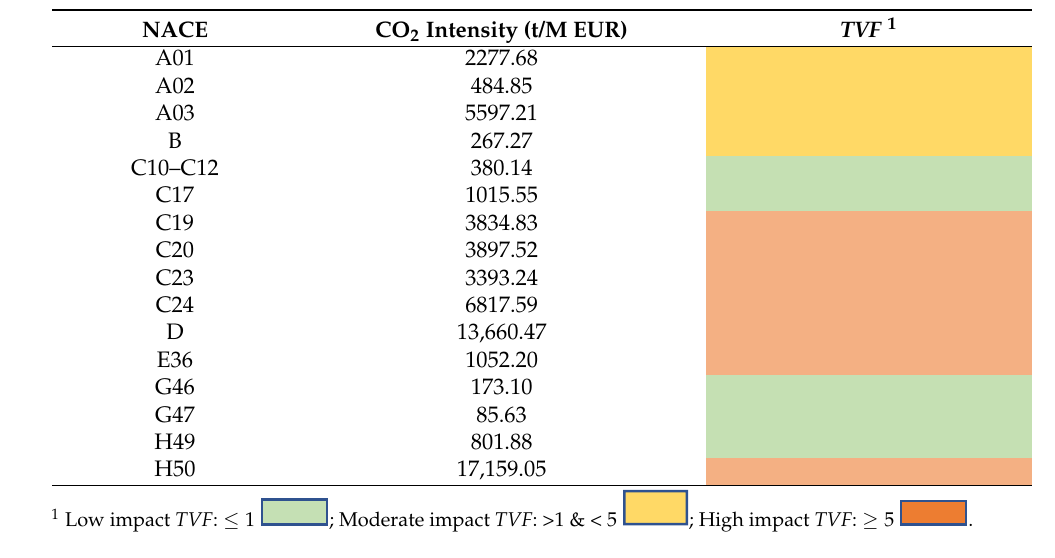
Table 3. Scenario for stress